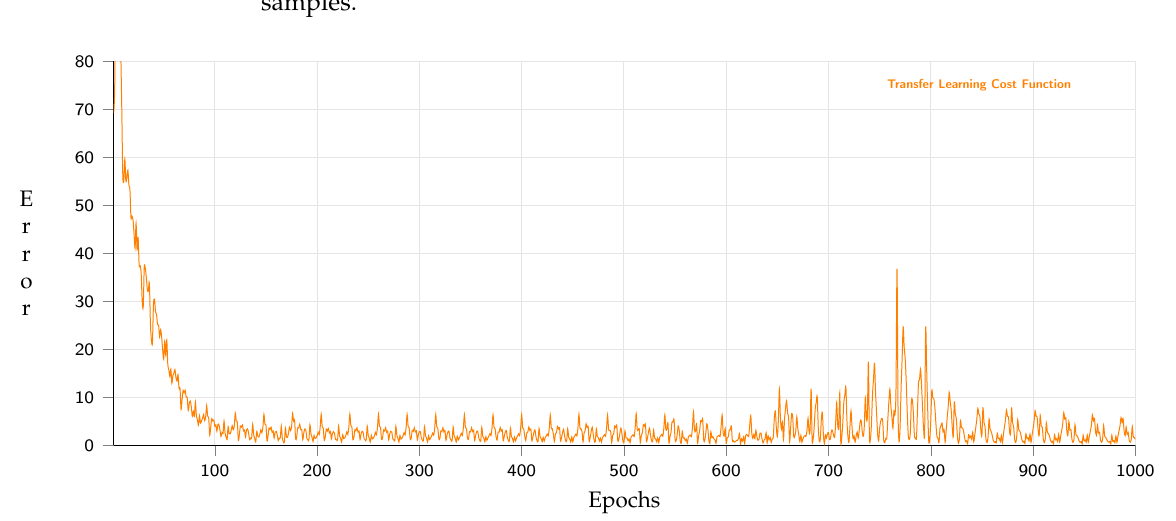
Figure 23. Behavior of the transfer-learning